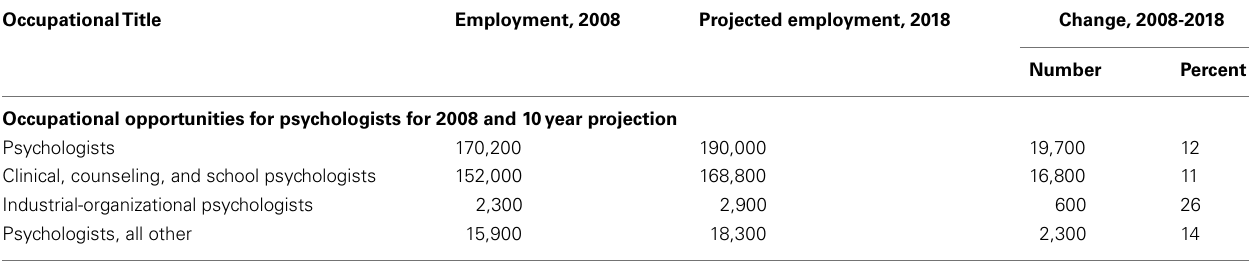
Table 3 | Employment by industry, occupation, and percent distribution 2008 and change projected